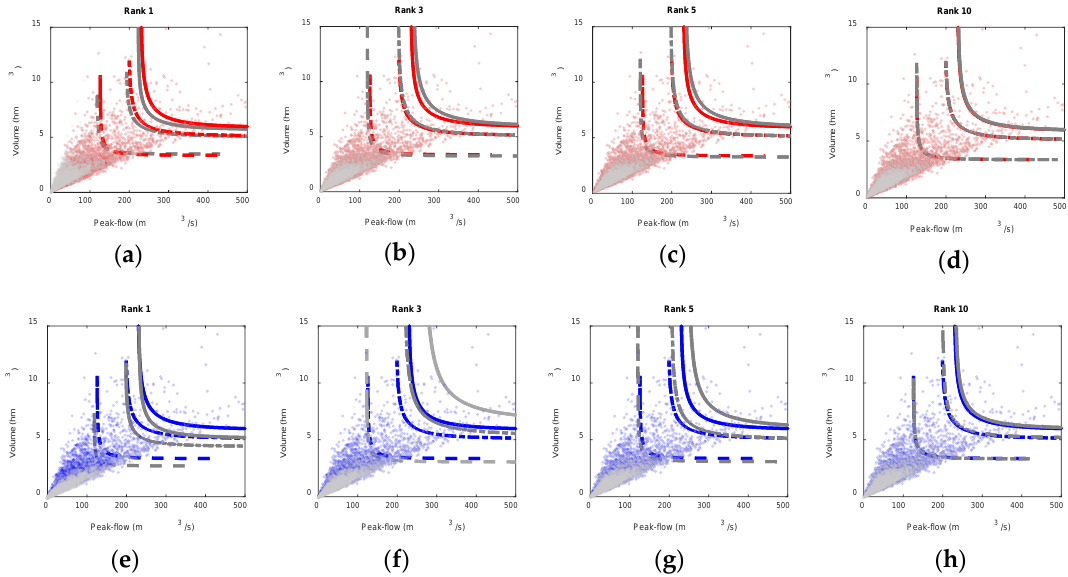
Figure 8. Chi-plots of maximum annual peak-flow and volume. Grey dots represent the values obtained considering specific storm orders up to different ranks ( a , e ) rank one ( b , f ) rank three, ( c , g ) rank five, ( d , h ) rank ten). Color dots represent the values obtained from the continuous simulation (red in ( a – d ), blue ( e – h )). Storm rank criteria is total depth in ( a–d ) and maximum intensity in ( e – h ).